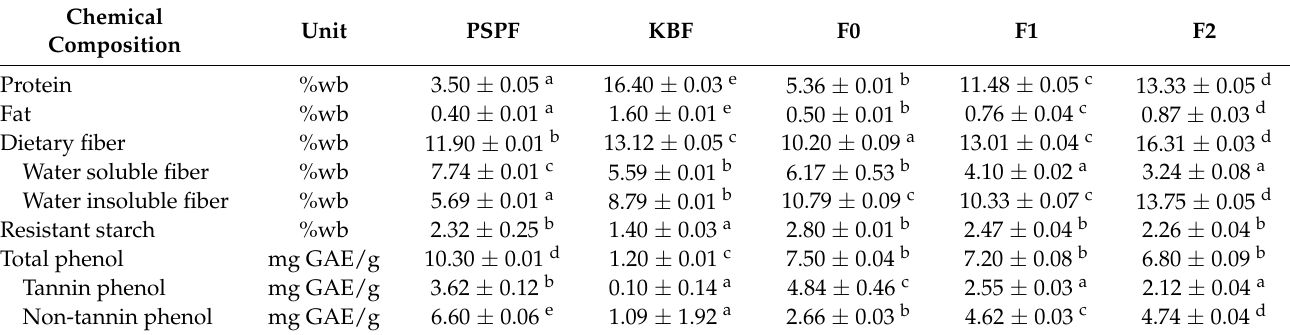
Table 3. Chemical compositions of PSPF, KBF, and the developed formulas (F0, F1, and